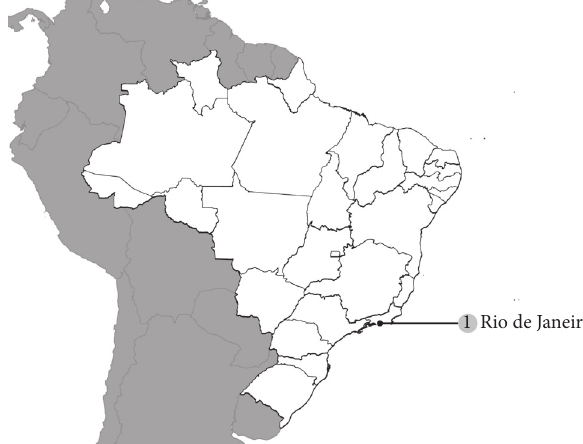
Figure 1: Map with georeference of MRSA reports showing the number of publications by isolation location during the